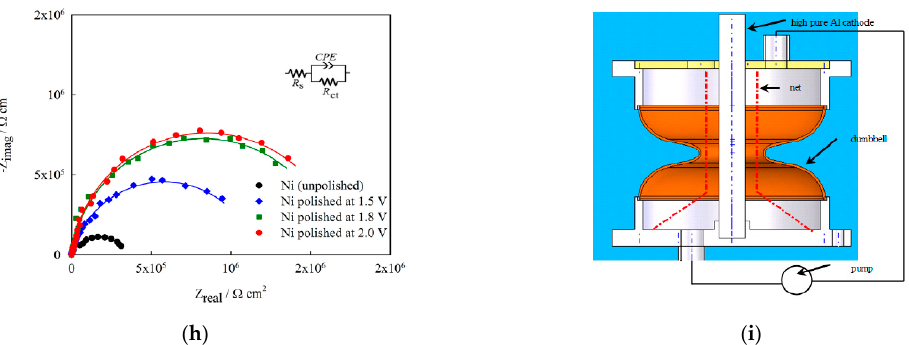
Figure 26. SEM images of damascene for 50 μ m patterns with Cu electropolishing at 1.75 V, ( a ) additive free, ( b – e ) four two additives (various organic acid + glycerol) electrolytic mixture, ( f ) illustration of two additive EP within damascene feature, ( g ) polishing rate on the inner and outer sides of damascene [166], ( h ) Nyquist plot showing enhanced corrosion of Ni in DES after EP at various voltages [35], ( i ) Schematic for 9 cell super conducting RF Niobium [23] (copyrights granted by Elsevier). Different additives have different polishing rates on Cu-damascene, with the viscous resistance of the passivation layer at the reacting interfaces. The reaction was more effective at the bottom and opening of the damascene. Weak acid at high concentrations enables the performance of accelerators in developing a resistive layer, and decreases local acidity. Hence, acetic acid has a superior performance to other electrolytes [166].